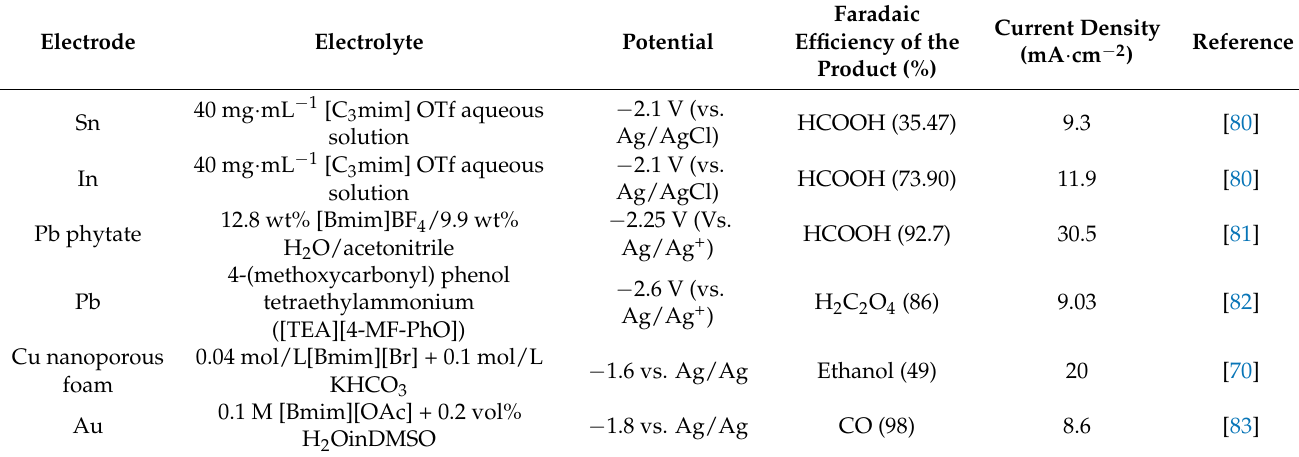
Table 2. Some examples of ionic liquids used in CO 2